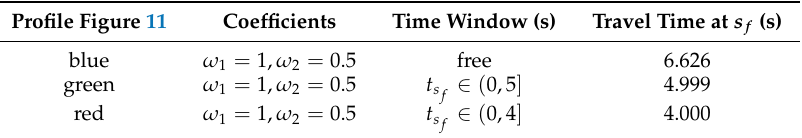
Table 4. Time Window